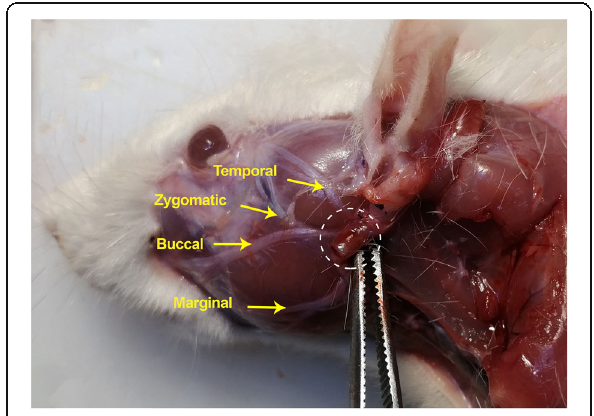
Fig. 2 Location of the silicone tube insertion in experimental groups, silicone tube is retracted rostrally and is denoted by dashed lines. The overlying anatomy was removed for a clear representation. Facial nerve branches are demonstrated by the